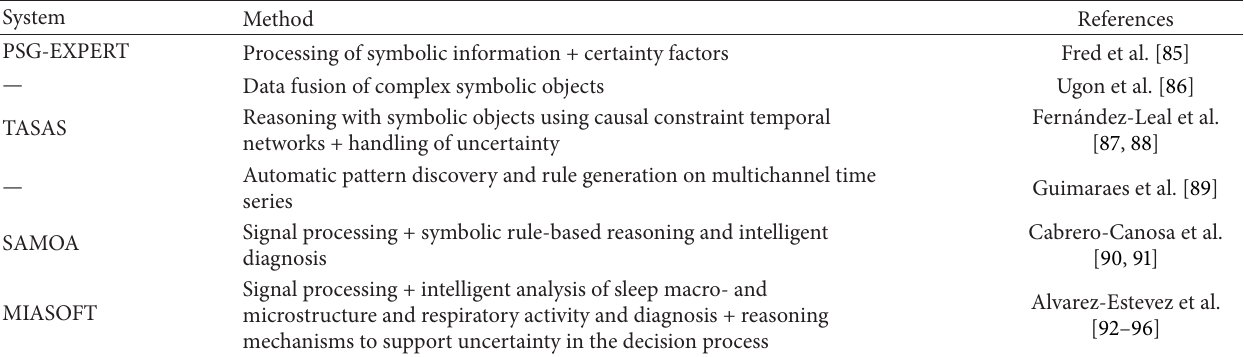
Table 7: Summary of comprehensive diagnostic